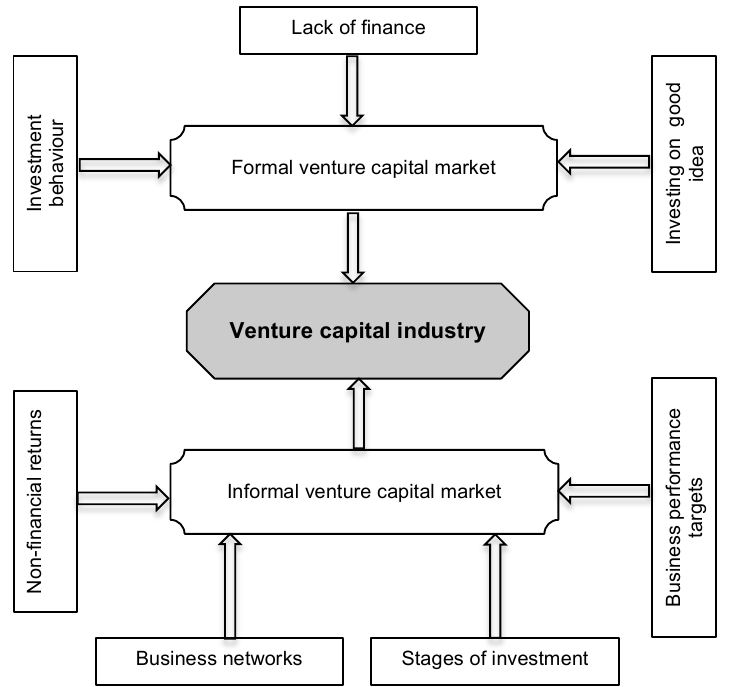
Dimensions influencing the venture capital market (conjoint framework for venture capital